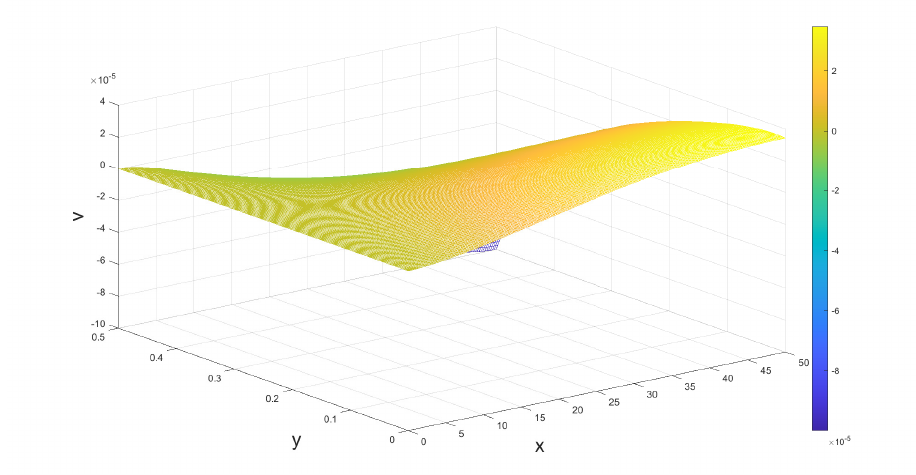
Figure 11. Surface plot of the v -velocity profile at t = 10.